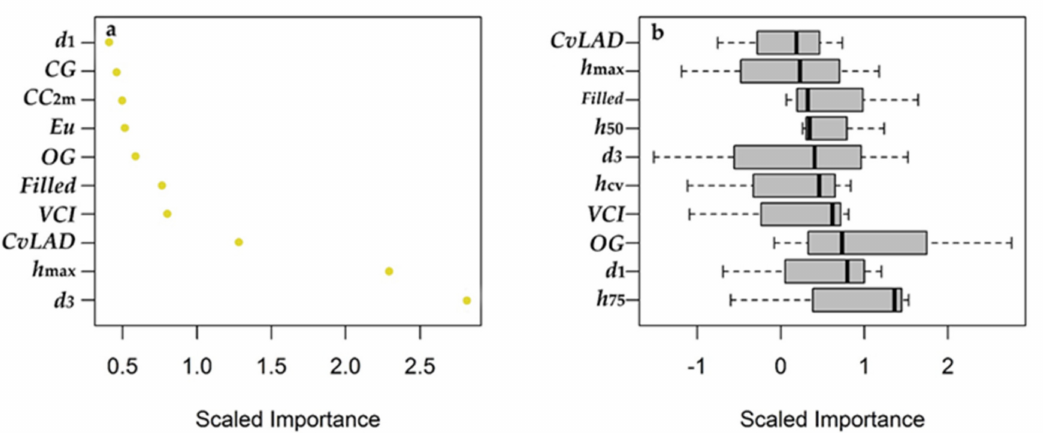
Figure 6. Scaled importance values of Light Detection and Ranging (LiDAR) metrics for RF imputations of all plots and Chinese fir plots. Scaled values were derived by calculating z-scores from the importance